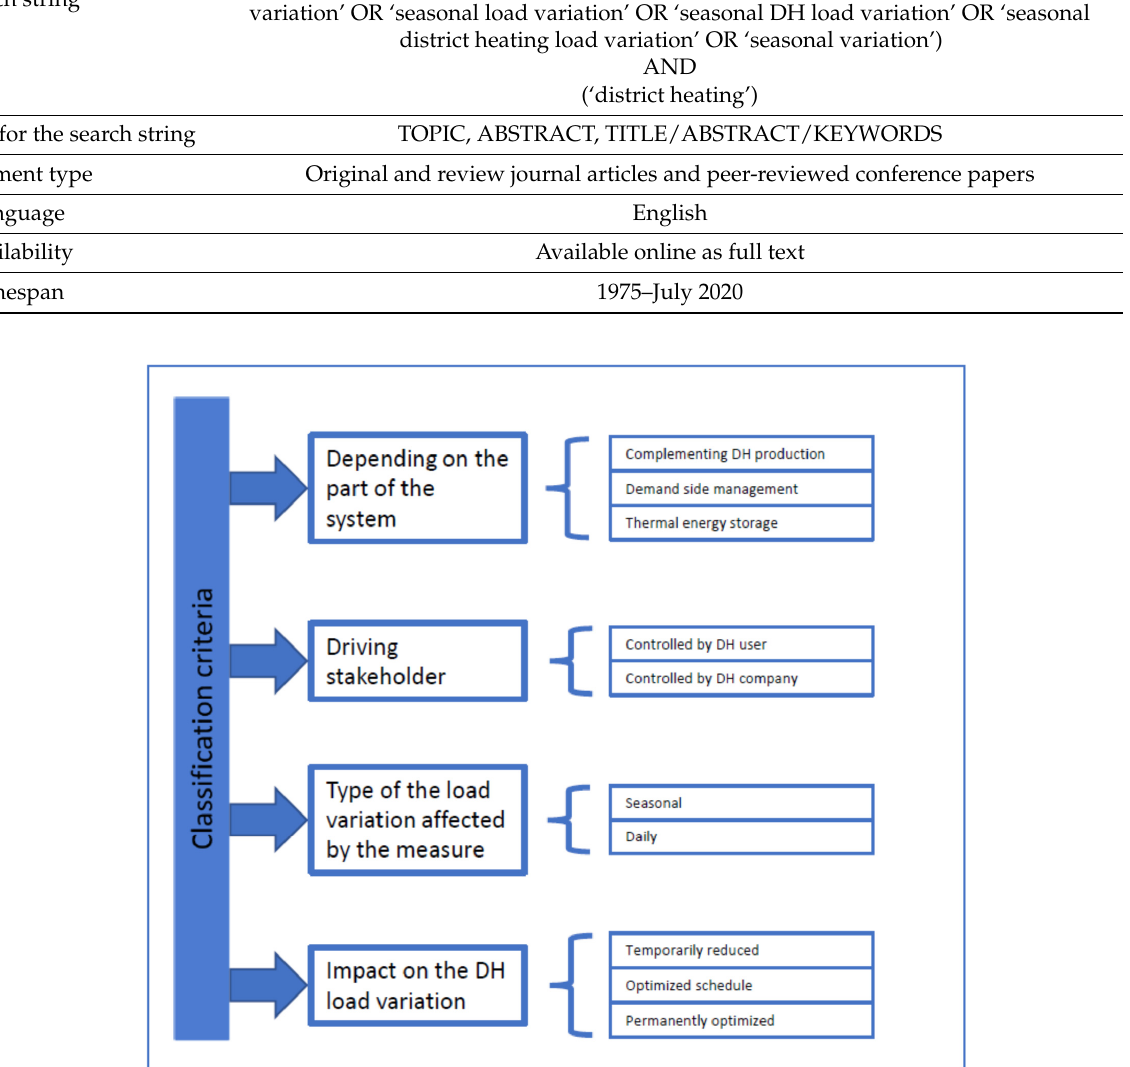
Figure 1. The interpretative framework.